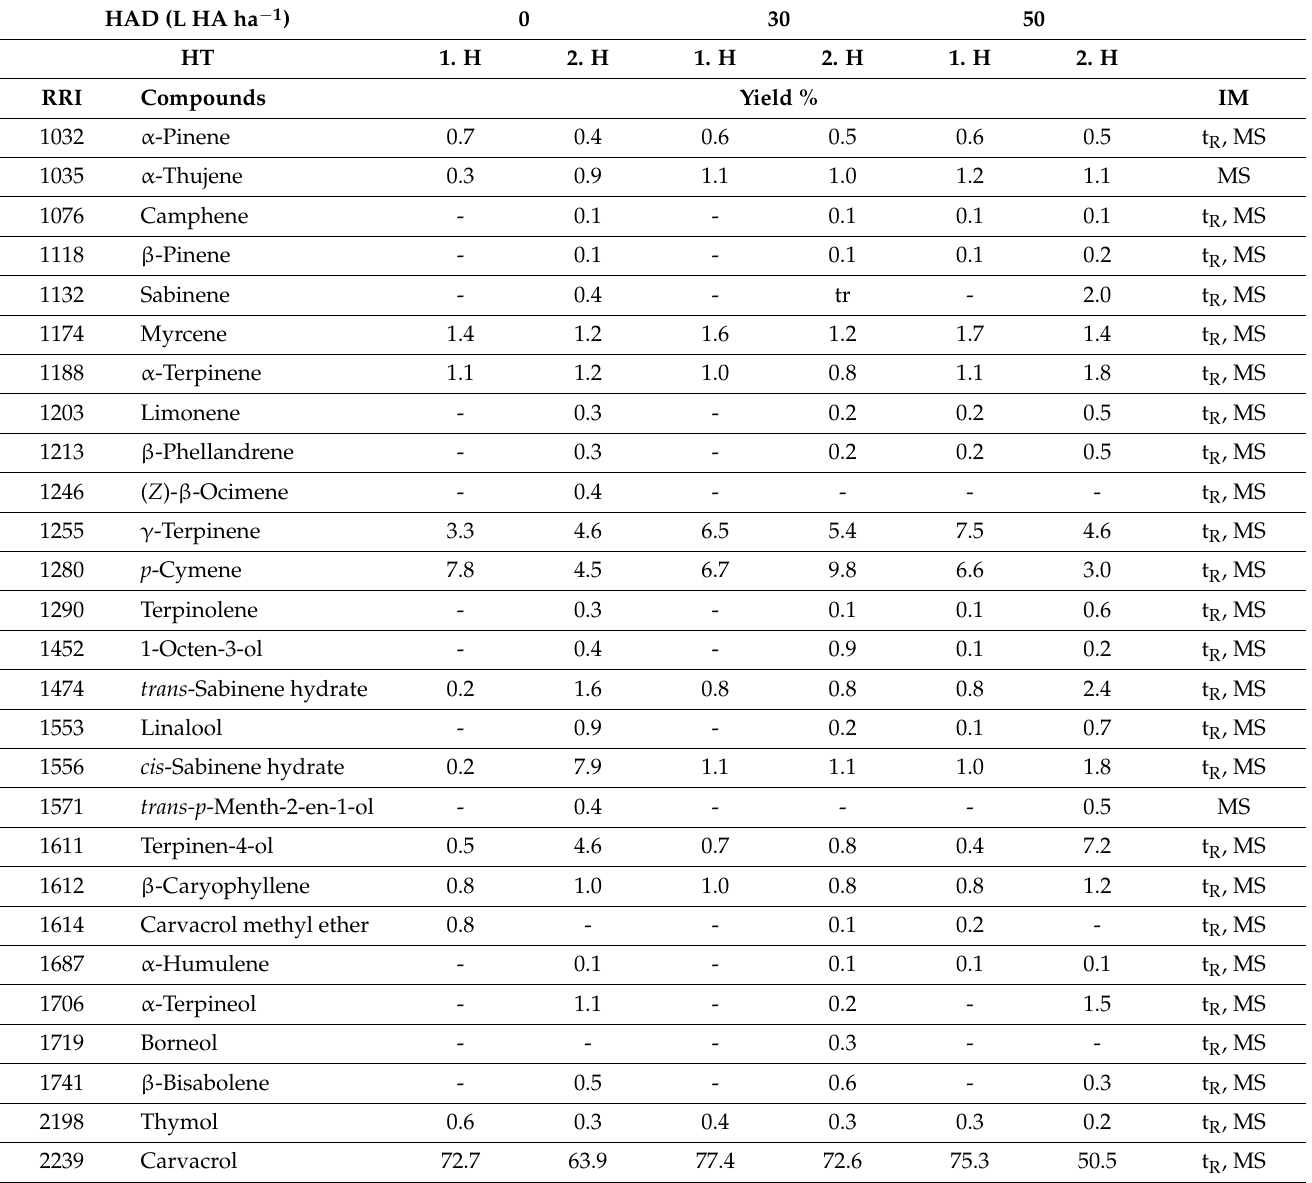
Table 7. Essential oil components of Origanum vulgare subsp. hirtum according to the different HT and HAD in